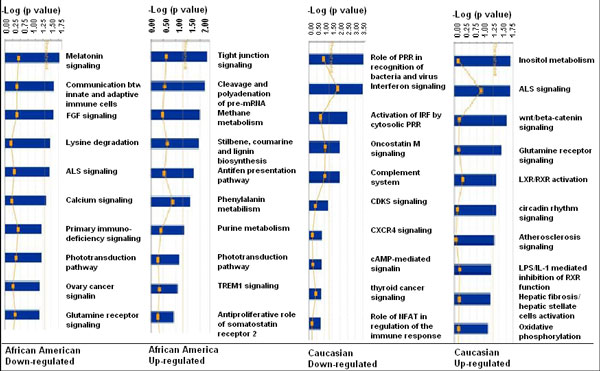
Pathway analyses using specifically regulated genes in AA and CAU. The top ten pathways were selected to present for specifically up- or down-regulated genes in AA and CAU patients. The significantly different genes were chosen to run the Ingenuity pathway tool. The bigger the -log(p-value) of a pathway is, the more significantly the pathway is regulated. The threshold lines represent a p value with 0.05.